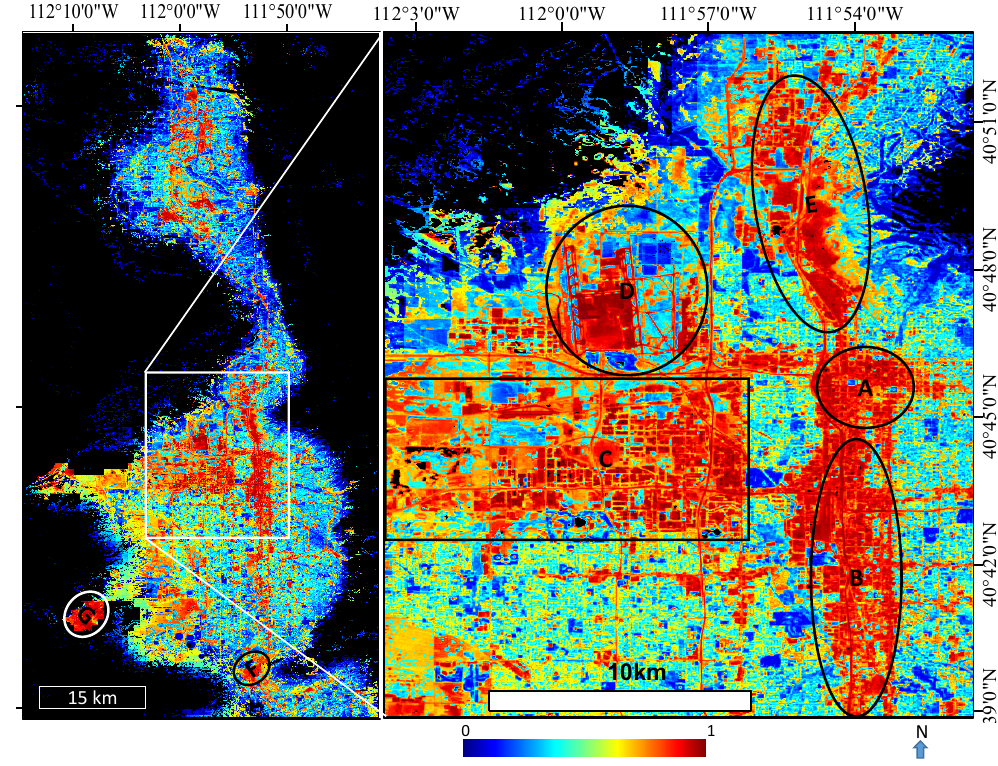
Figure 10. A close-up look at the urban areas of the Salt Lake City region. ( A ) Downtown of Salt Lake City; ( B ) commercial strip; ( C ) industrial zone; ( D ) Salt Lake City International Airport; ( E ) industrial Zone; ( F ) sand pit at the Point of the Mountain; ( G ) Bingham Canyon Open-Pit Copper